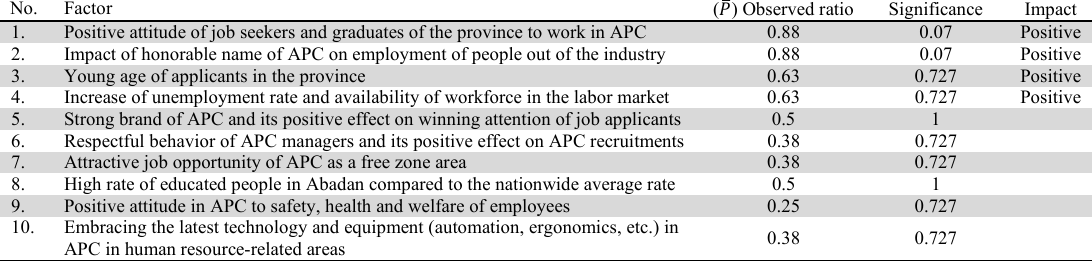
Human source opportunities